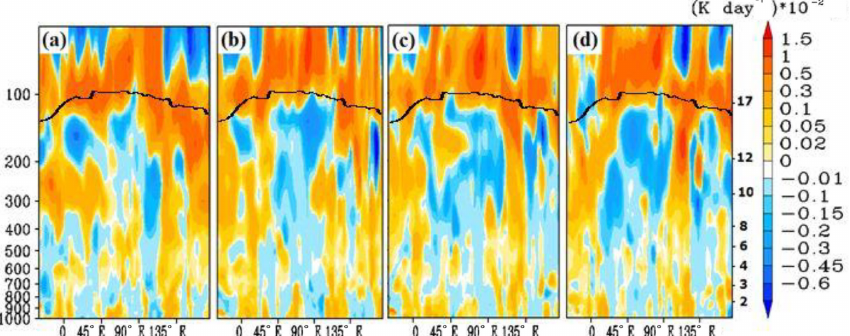
Figure 9. Longitude-pressure distribution (averaged for 18–20 ◦ N) of anomalies of ozone heating rates ((Kday − 1 ) × 10 − 2 ) for (a) 2 July, (b) 4 July, (c) 6 July and (d) 8 July 2003. Pressure (hPa) is indicated on the left y axis and altitudes (km) on the right y axis. The thick black line indicates the